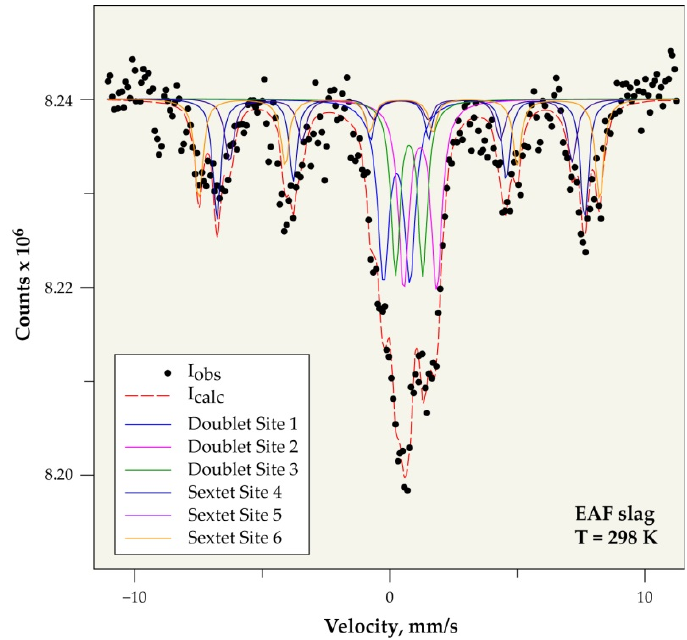
Figure 9. Mössbauer spectrum of slag at room temperature.